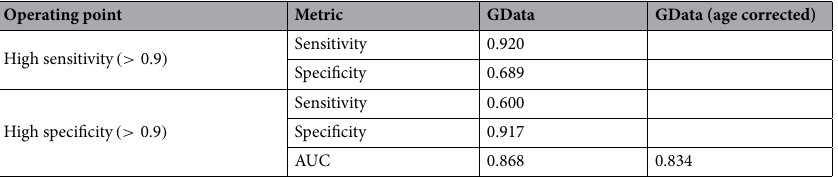
Table 3. Experimental results of an ensemble of 10 fused multi-label models trained on the SData set ( n = 22 ) and evaluated on the GData set ( n = 157 ) for the detection of PD. The AUC in the age corrected GData column refers to the mean AUC across 10 randomly generated, age-matched GData subsets (as such, we do not report performance metrics values at the two operating points for this